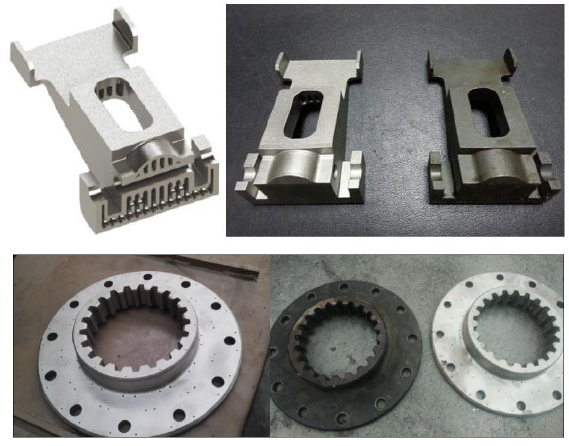
Figure 28. Final redesigned stopper ( up ) and connecting plate ( down ) with original parts.